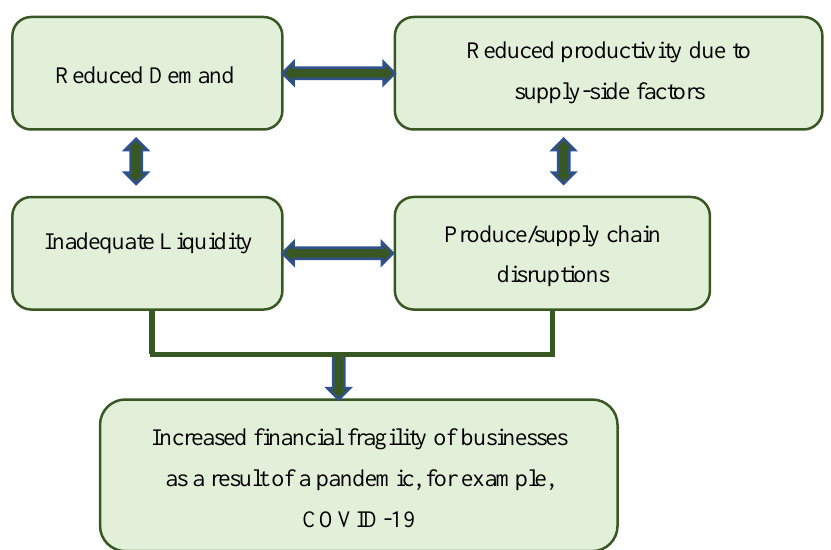
Figure 3. Pandemics can result in all the economic effects stated above and thereby increase in the financial vulnerability of potentially affected businesses. These effects are often independent.